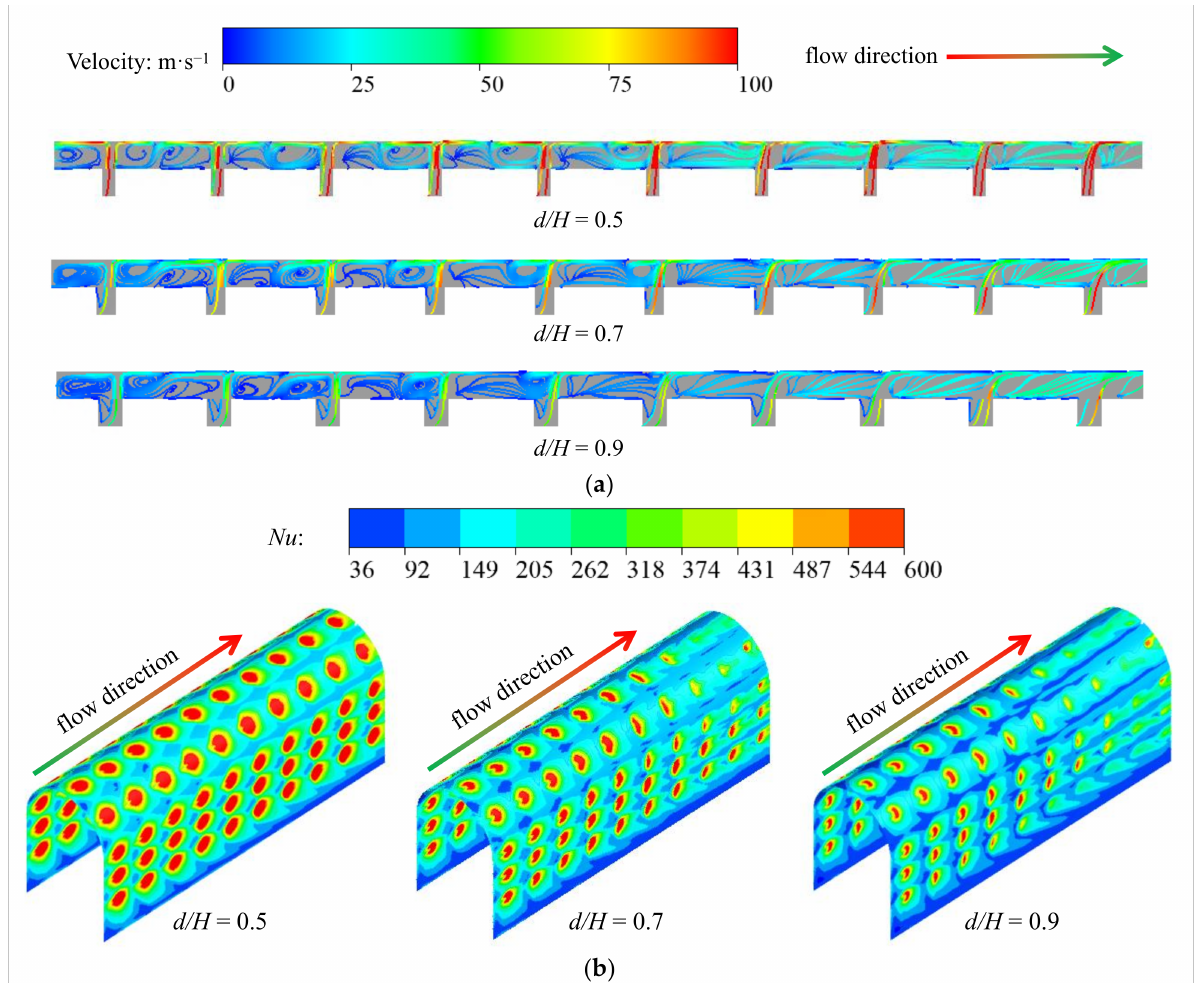
Figure 9. Distributions of flow field and heat transfer at different d/H under steam cooling: ( a ) flow field distributions; ( b ) heat transfer